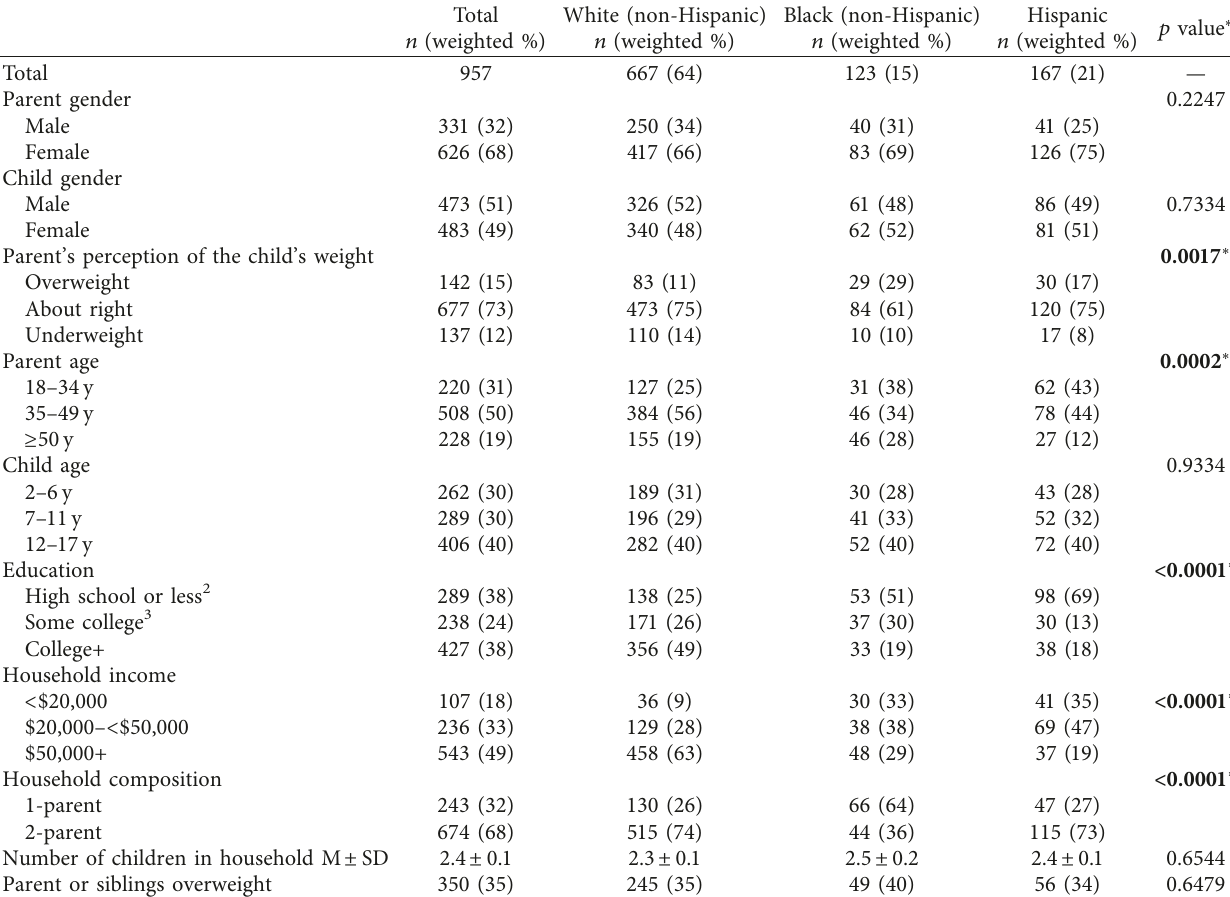
Table 1: Characteristics of the study sample, by parent +